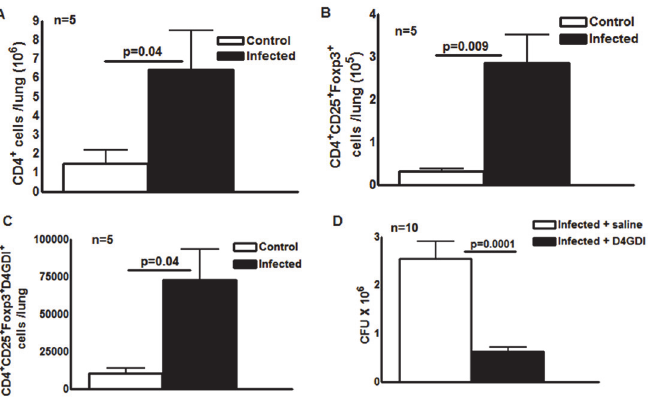
Figure 4. D4GDI inhibits growth of M. tb in mice. Ten wild type C57BL/6 mice were infected with 50 – 100 CFU of H37Rv by aerosol. Five mice were sacrificed after 24 hr and the bacterial burden in lungs was confirmed to be 50 – 100 CFU. The remaining five mice were sacrificed after 30 days. Total number of (A) CD4 + cells (B) CD4 + CD25 + Foxp3 + cells (C) CD4 + CD25 + Foxp3 + D4GDI + cells in the lungs of uninfected and M. tb -infected mice were measured by flow cytometry. (D) Twenty C57BL/6 wild type mice were infected with 50 – 100 CFU of M. tb H37Rv by aerosol. Ten infected mice were given recombinant D4GDI (10ng/ml) through tail vein injection on day 0, 4, 8, 12, 16, 20, 24 and 28 after infection. Thirty days later, bacterial burden in the lungs was measured by plating lung homogenates and counting CFU. Mean values, p values and SEs are